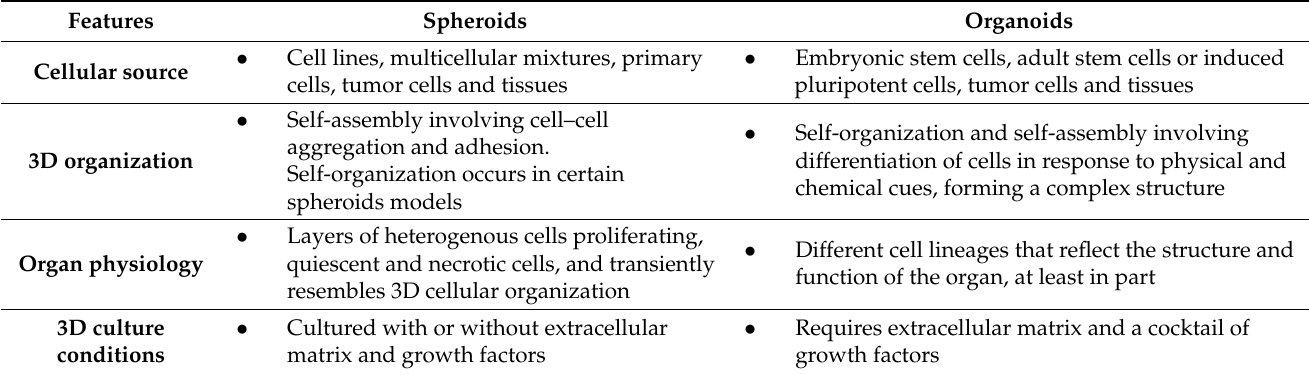
Table 2. Comparison of spheroids and organoid